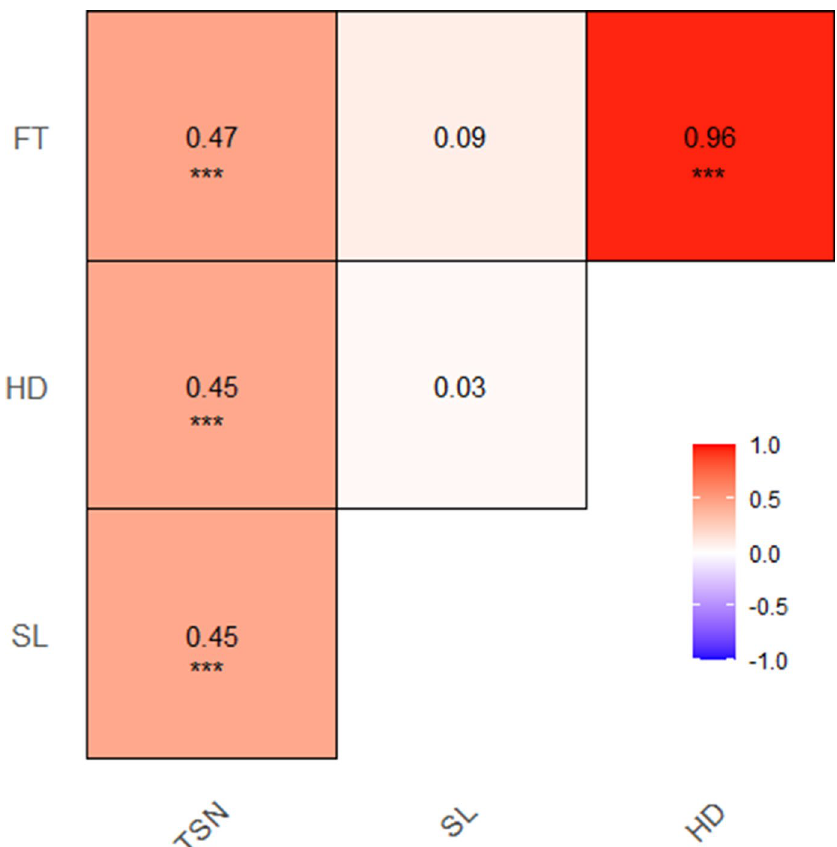
Figure 2. Pearson’s correlation coefficient of the best linear unbiased estimations (BLUEs) of total spikelet number (TSN), spike length (SL), heading date (HD), and flowering time (FT). Significance of the correlations is indicated with *** P <